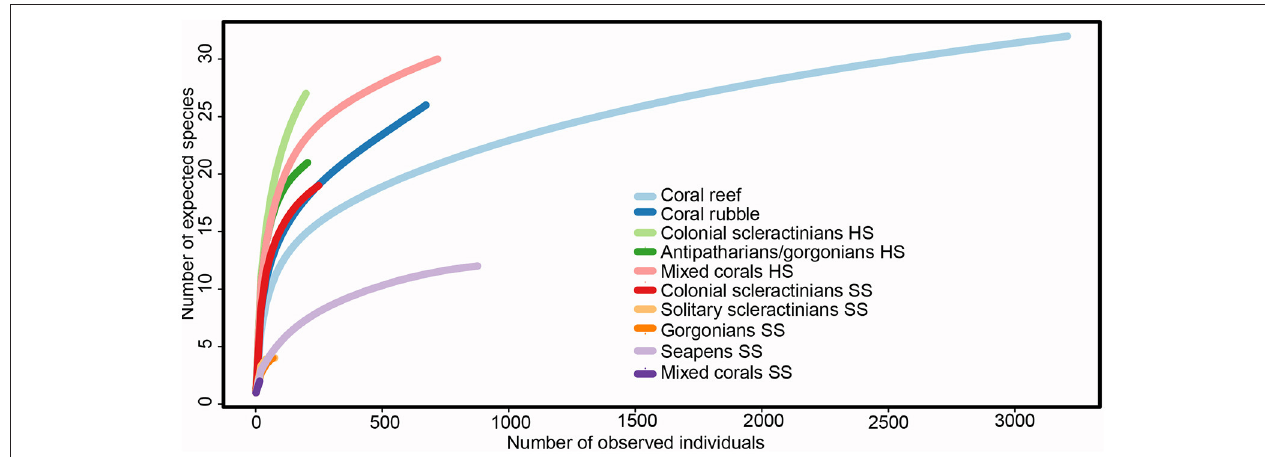
FIGURE 3 | Rarefaction curves of the coral habitats, excluding the reef-forming scleractinians M. oculata , L. pertusa, and S. variabilis . The number of species (y-axis) is based on the number of individuals (x-axis) in each habitat. Each color represents a different coral habitat.